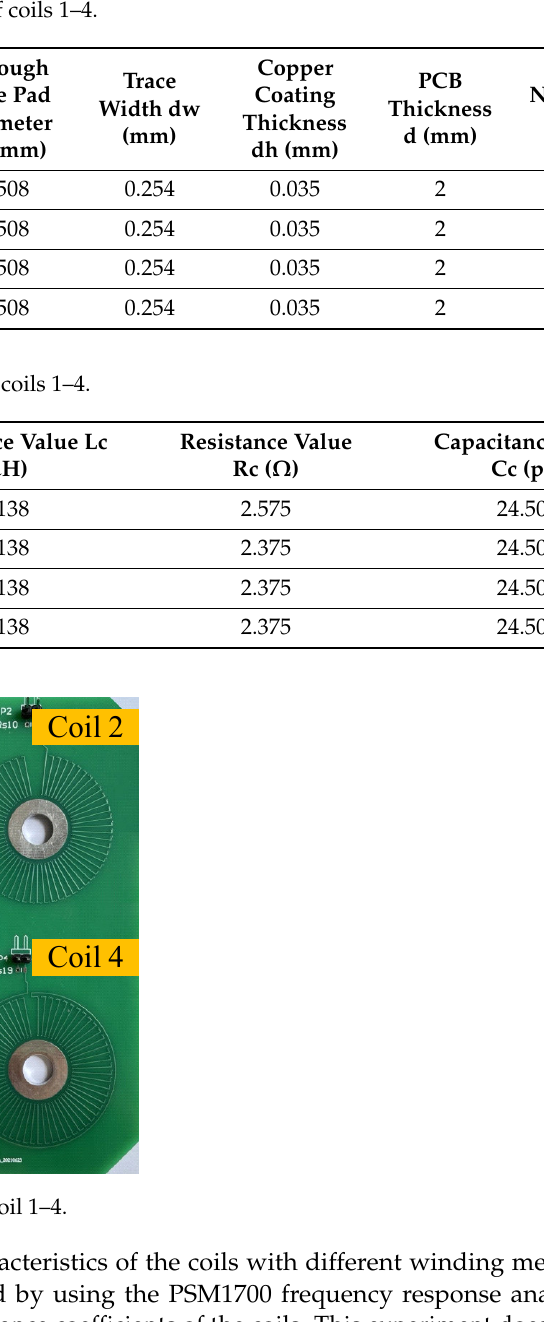
Figure 11. Experimental framework [30].